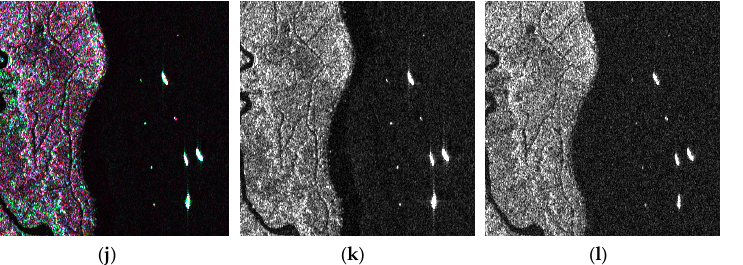
Figure 8. Comparison of VV and VH polarized images with corresponding DSSDD data. ( a , d , g , j ) are pseudo-color maps, ( b , e , h , k ) are VV polarized images, and ( c , f , i , l ) are VH polarized data. Our pseudo-color image had the advantage of weakening the sidelobe and land noise on hulls and clarified the ship skeleton.